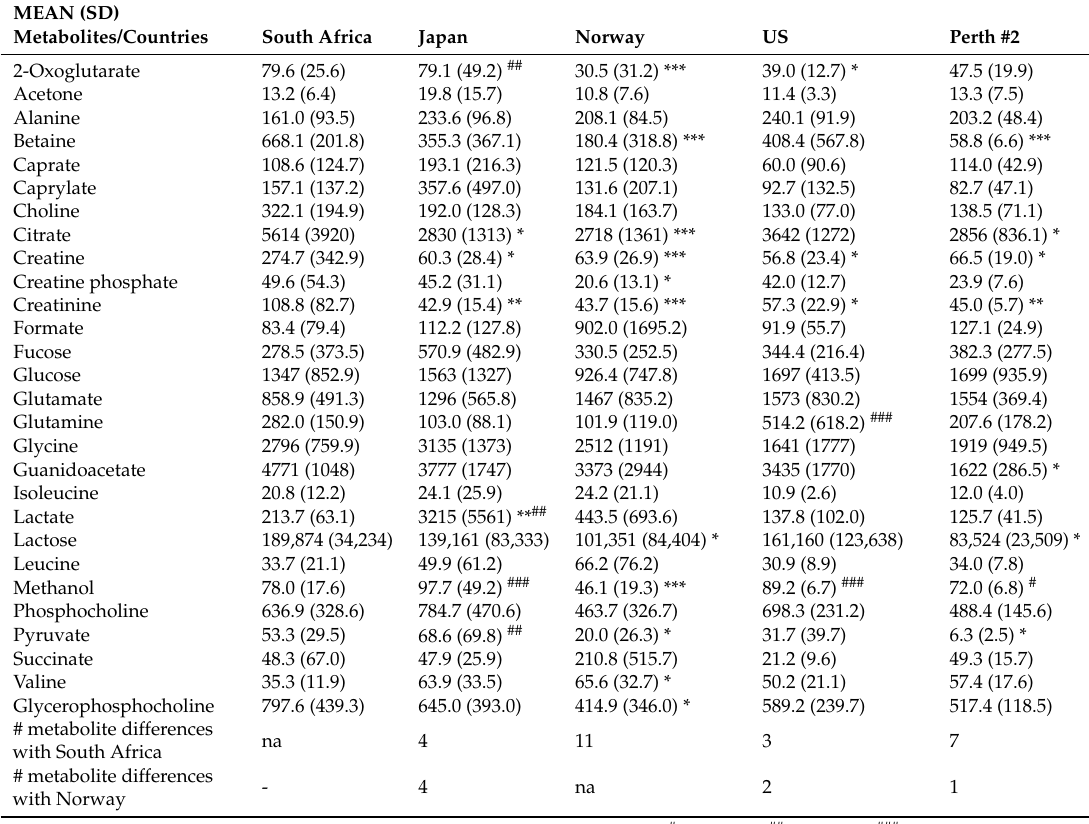
Table 1. Comparison of milk metabolites concentrations ( µ mol/L) by country of origin. MEAN (SD)